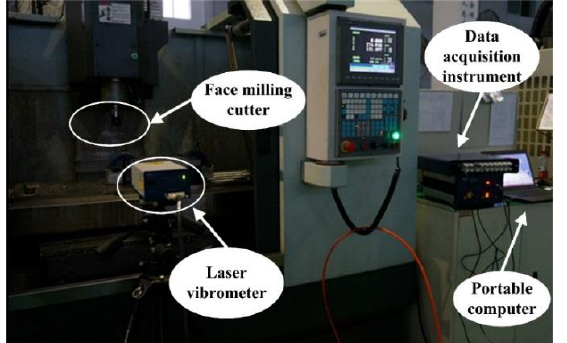
Figure 2. Experiment design.